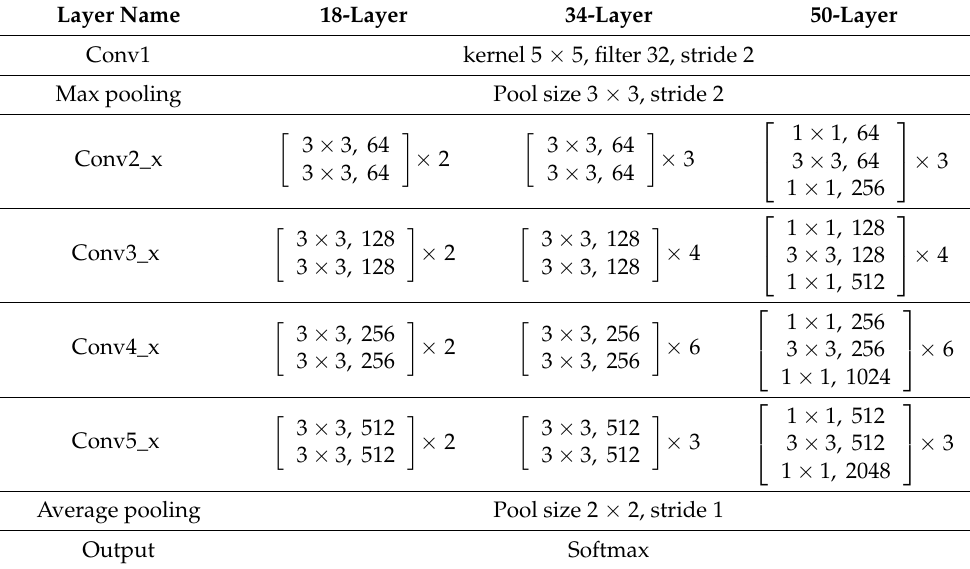
Figure 6. Building residual block. F(x), residual; x, input. Table 7. ResNet model